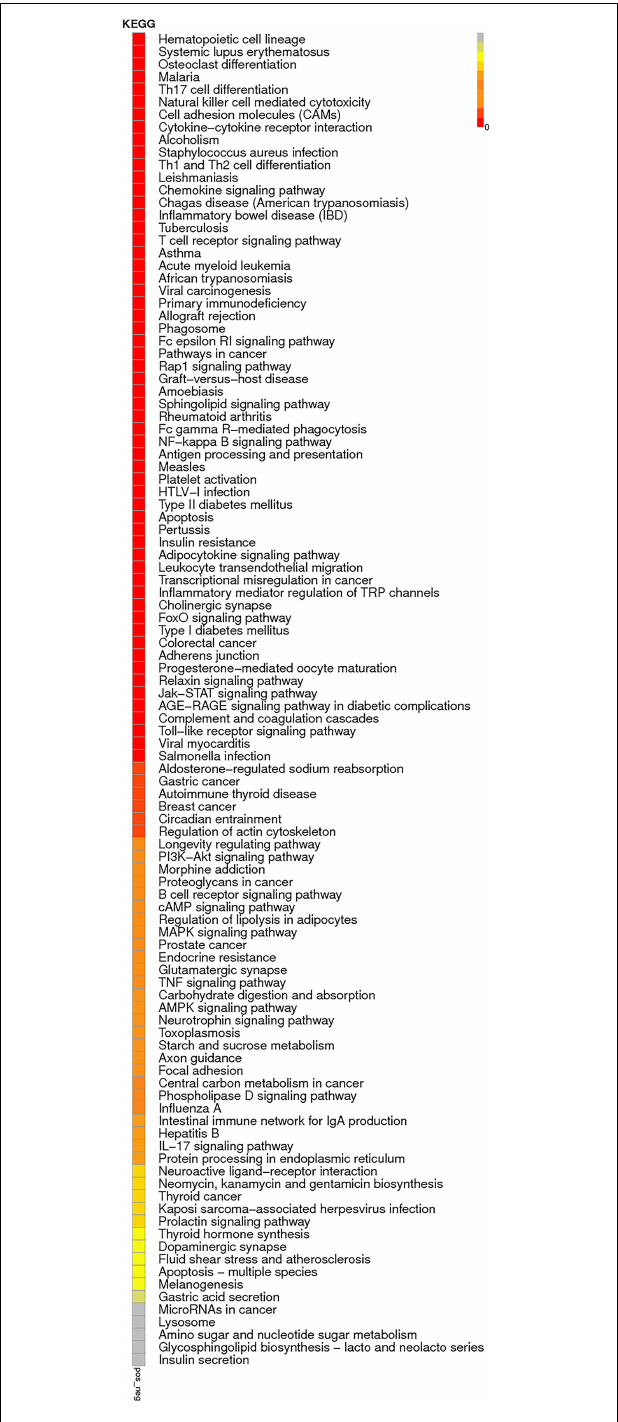
FIGURE 10 | KEGG pathway of